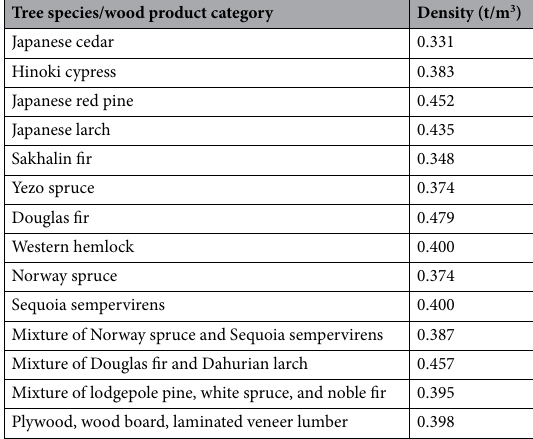
Table 2. Wood density (oven dry mass over air dry